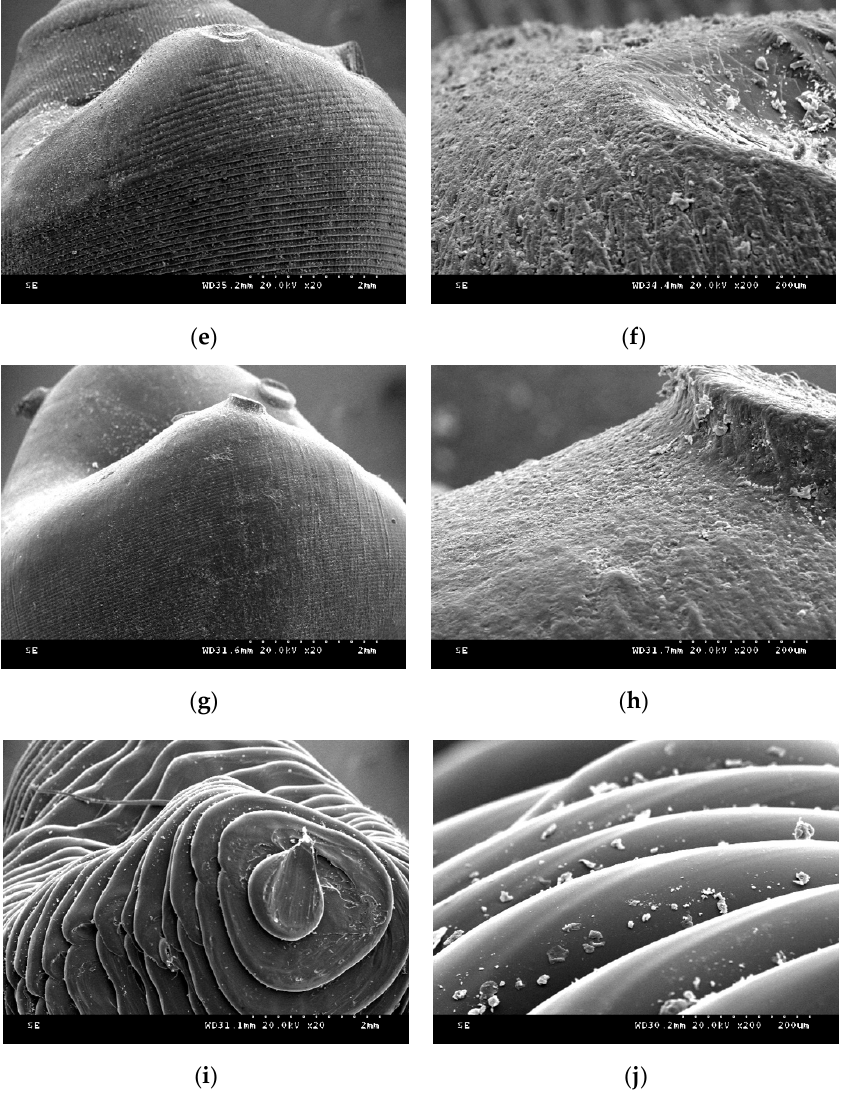
Figure 7. Scanning electron microscopy images after postprocessing procedure (oblique buccal view at buccal cusp tip of premolar). ( a ) CV (original magnification ×20); ( b ) CV (original magnification ×200); ( c ) SM (original magnification ×20); ( d ) SM (original magnification ×200); ( e ) DLP (original magnification ×20); ( f ) DLP (original magnification × 200); ( g ) SLA (original magnification ×20); ( h ) SLA (original magnification ×200); ( i ) FDM (original magnification ×20); ( j ) FDM (original magnification ×200).